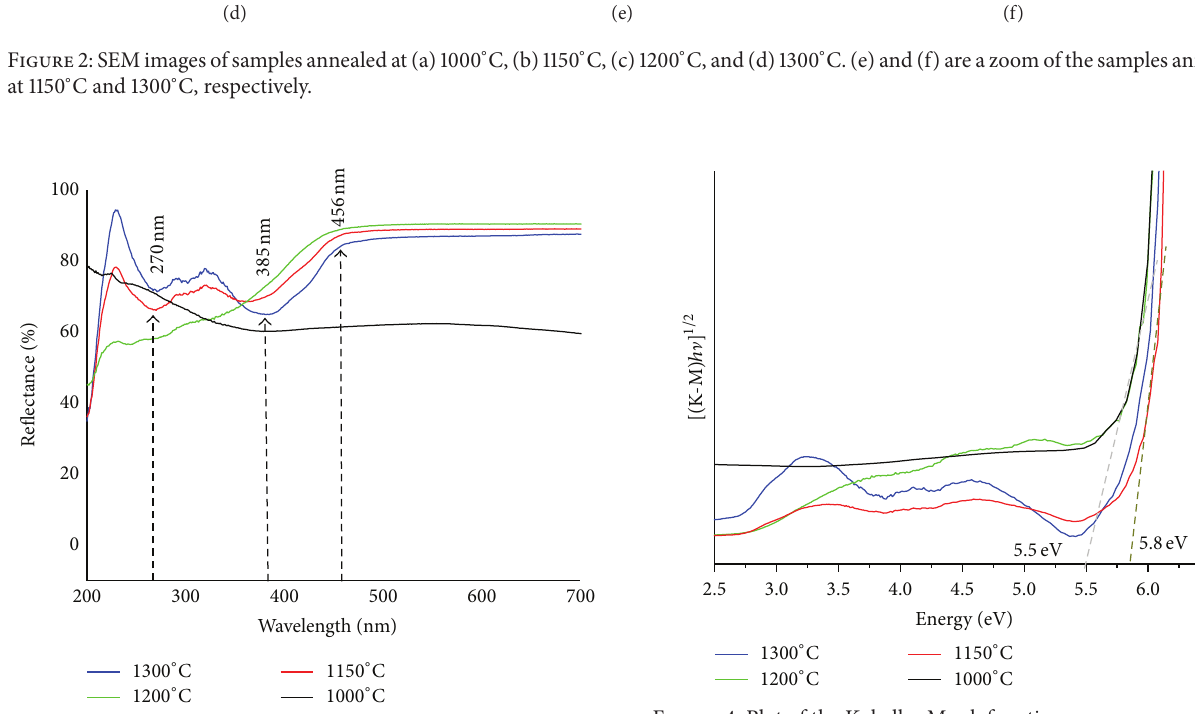
Figure 3: Reflectance diffuse spectra of the samples annealed at different temperatures.